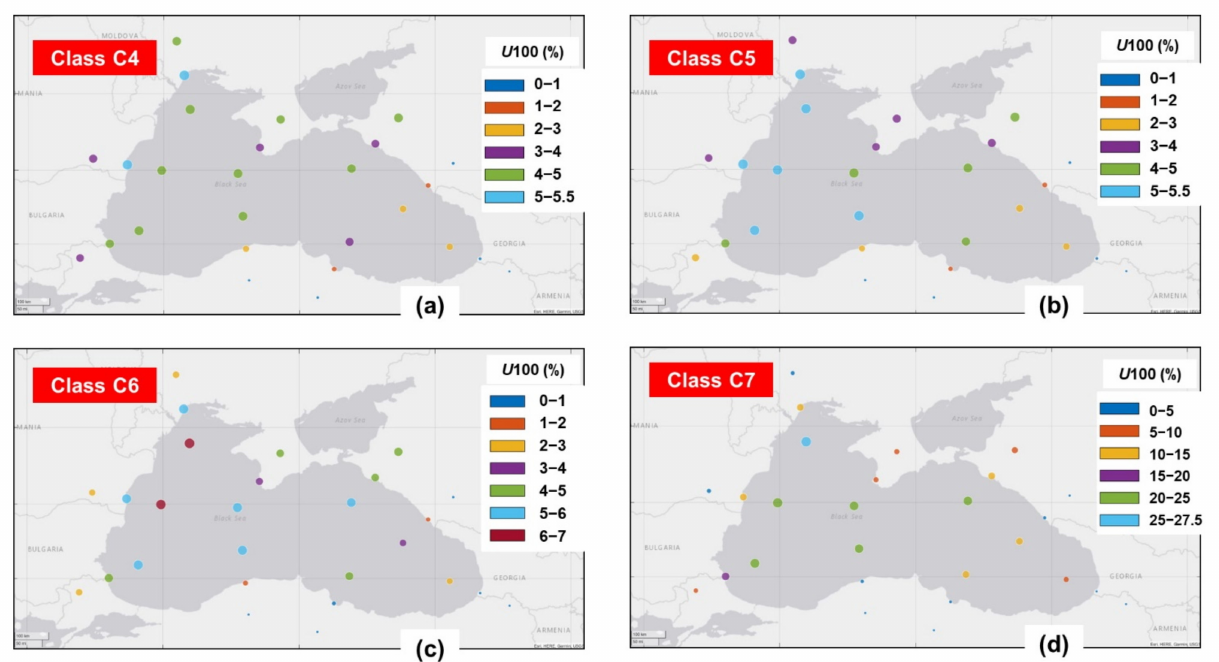
Figure 6. Distribution of U 100 parameter by wind classes processed for the entire 20-year time period (2002–2021), where: ( a ) class C4; ( b ) class C5; ( c ) class C6; ( d ) class C7. This classification was made according to the information provided in Oh et al. [19].